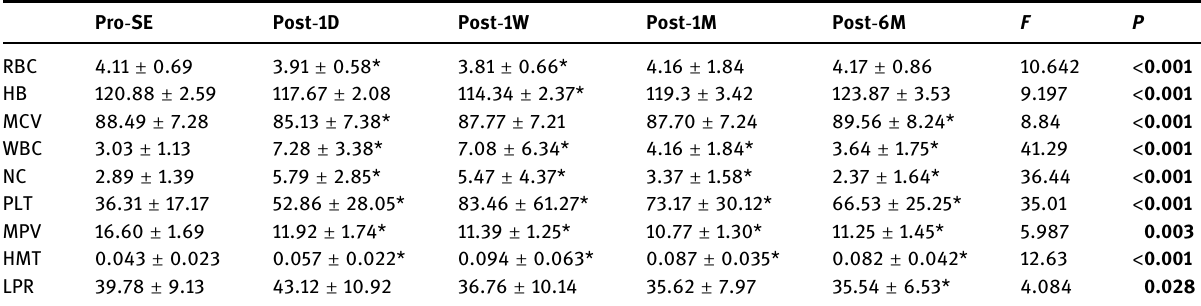
Table 3: Comparison of blood cell index before and after splenic embolization Pro - SE Post -